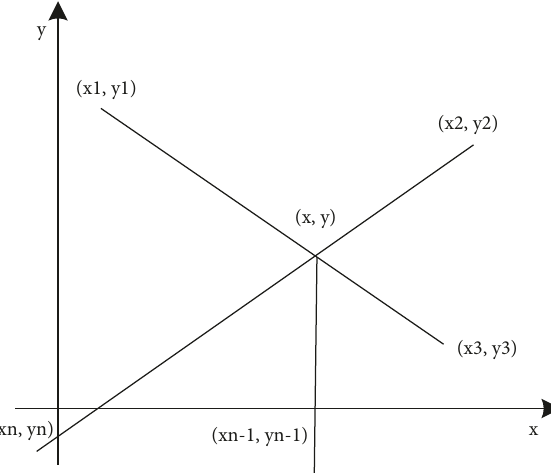
Figure 4: Graph of the precise center-of-gravity